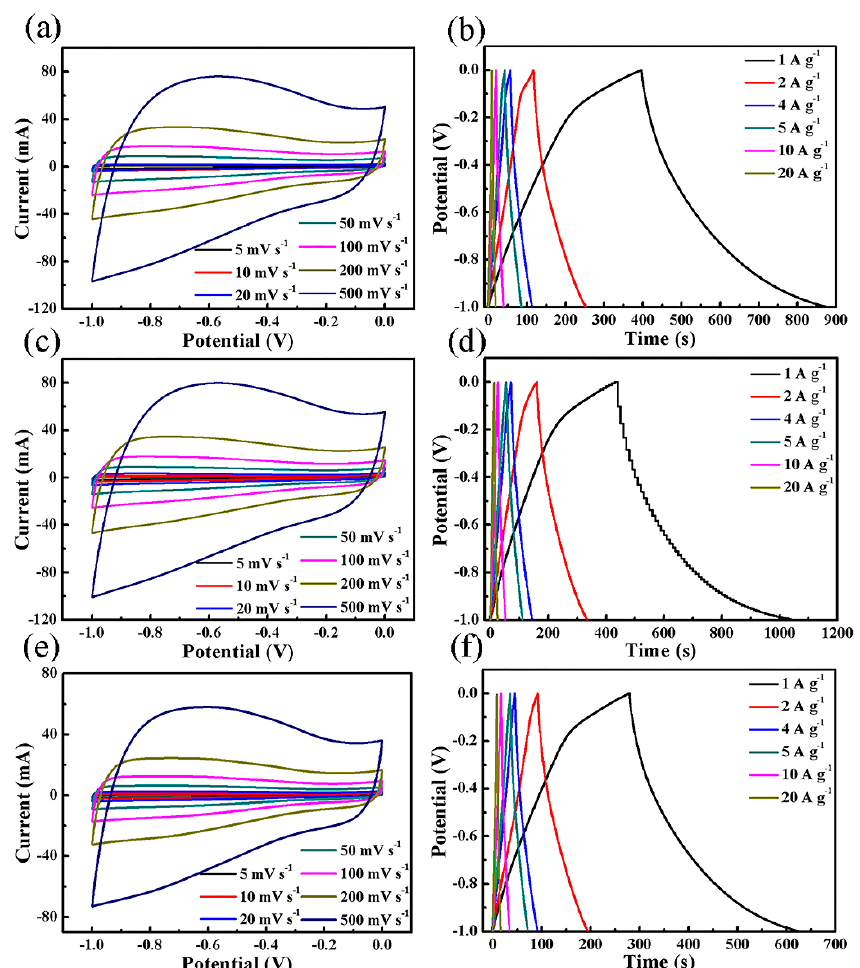
Figure 6. Cyclic voltammetry (CV) curves ( a , c , e ) at different scan rates and galvanostatic charge-discharge curves ( b , d , f ) at different current densities for CNFs, N CNFs-1 and N CNFs-2, respectively.